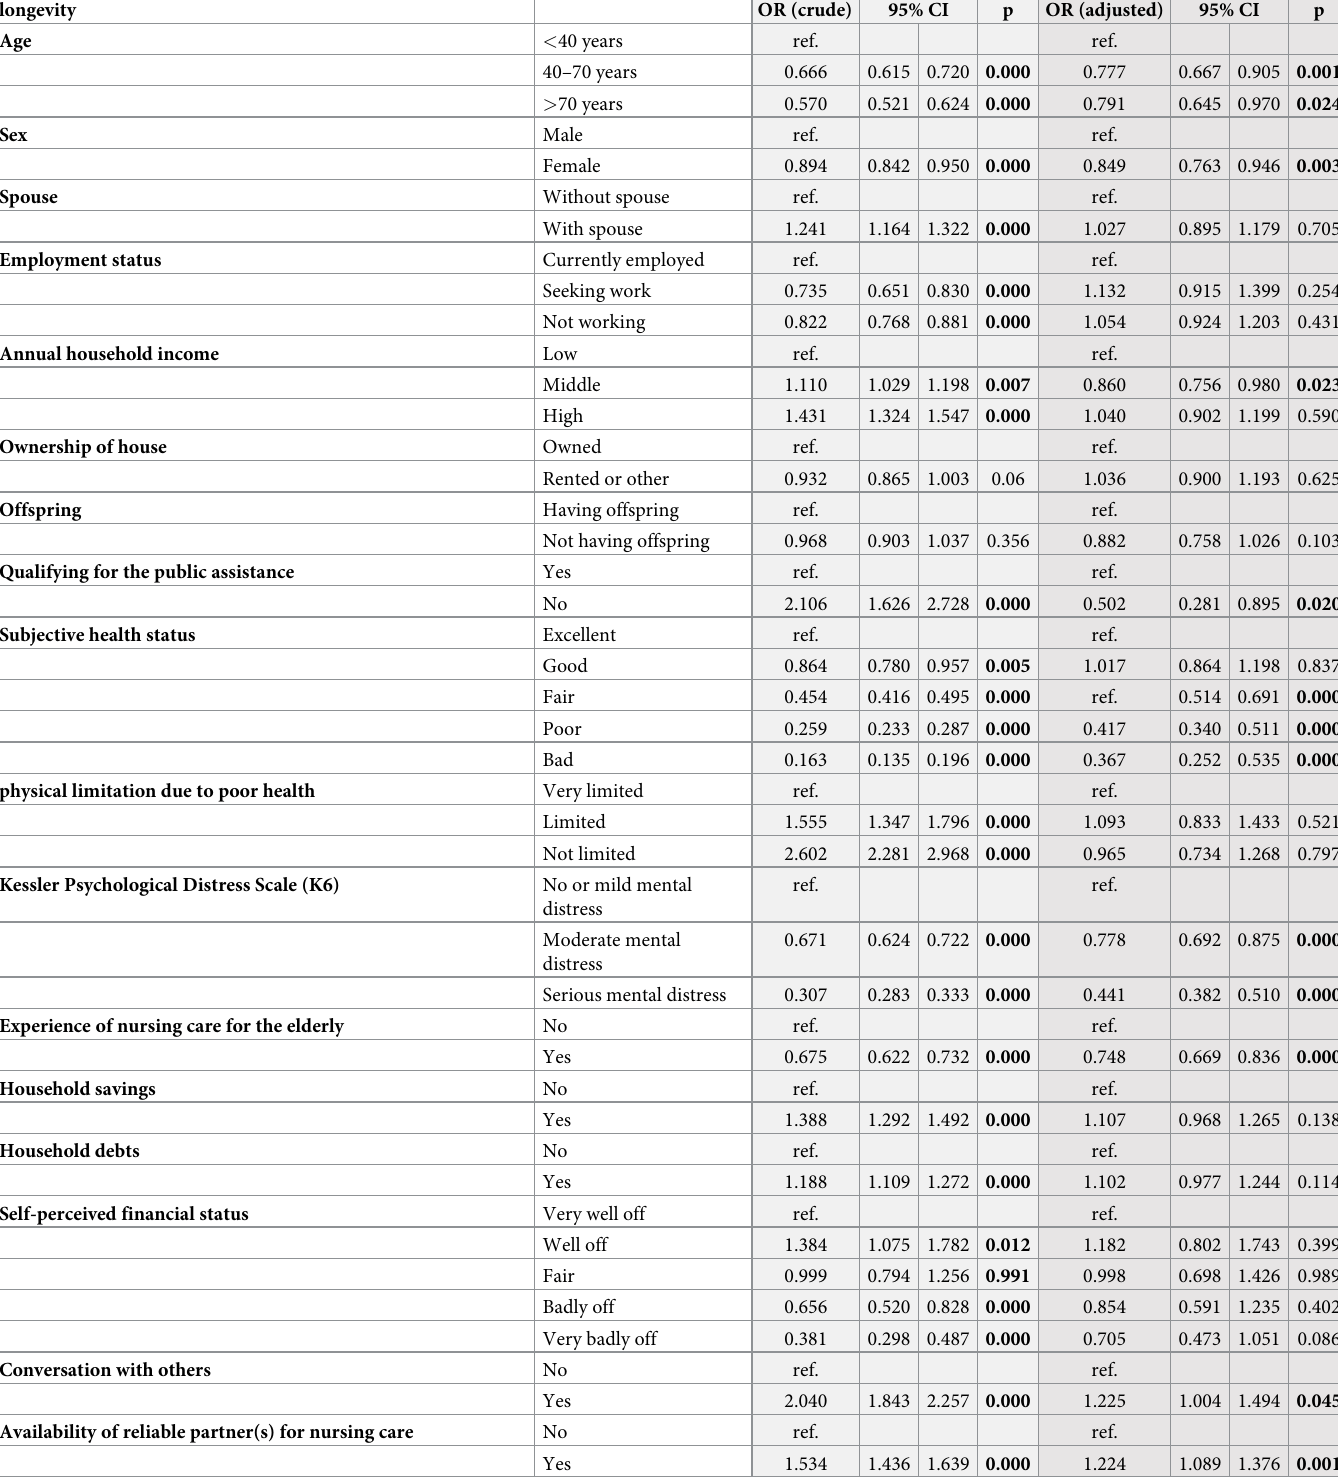
Table 3. Crude and adjusted OR of the individual anticipation for